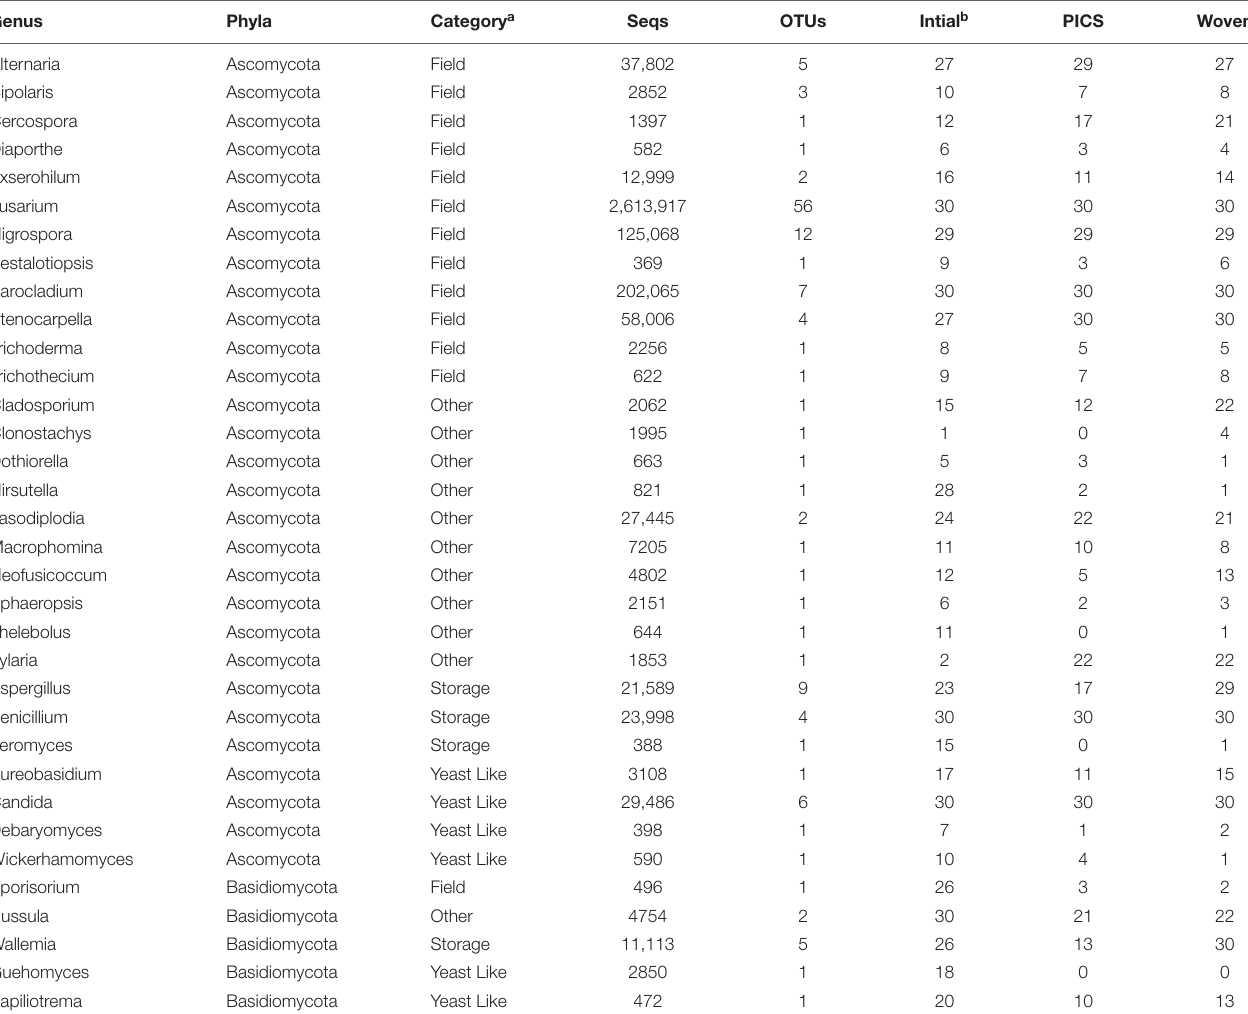
TABLE 4 | Genera identified from OTUs in Kenya grain after 3 months of